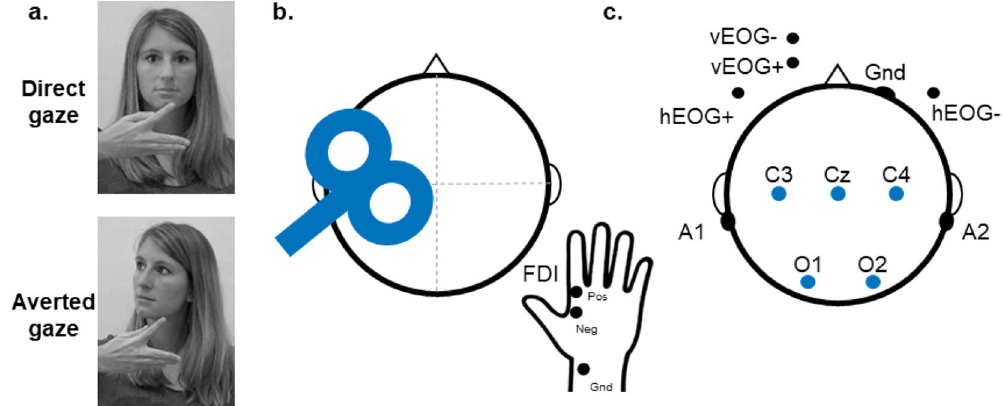
Figure 1. Experimental set-up. ( a ) Illustration of the experimental stimuli, showing a live stimulus person conveying direct or averted gaze while performing a simple finger abduction movement. The stimulus person gives consent to publish this image in an open-access publication of Scientific Reports. ( b ) MEPs induced by TMS over the left primary motor cortex were recorded from EMG electrodes located on the FDI index finger muscle of the right hand. (c) Continuous EEG was acquired from electrode sites C3, Cz and C4 to calculate mu suppression, and sites O1 and O2 for alpha